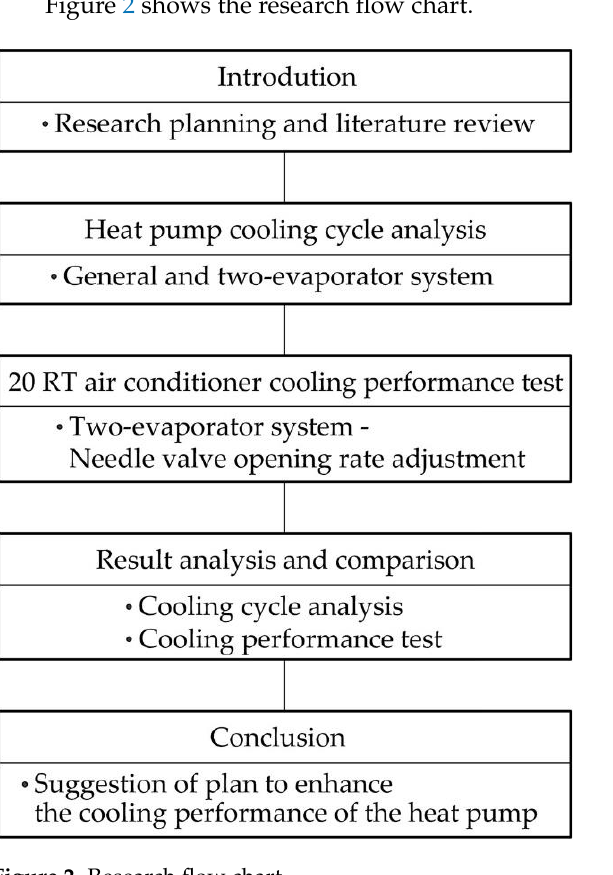
Figure 2. Research flow